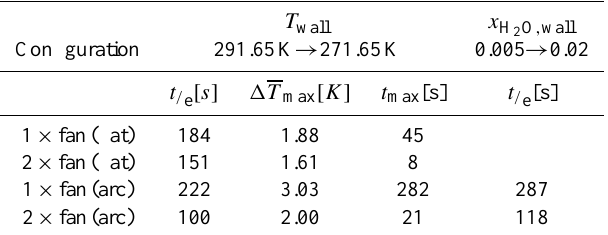
Table 1. 1/e volume-to-surface exchange times for an instantaneous change of wall temperature or water mass fraction for different fan